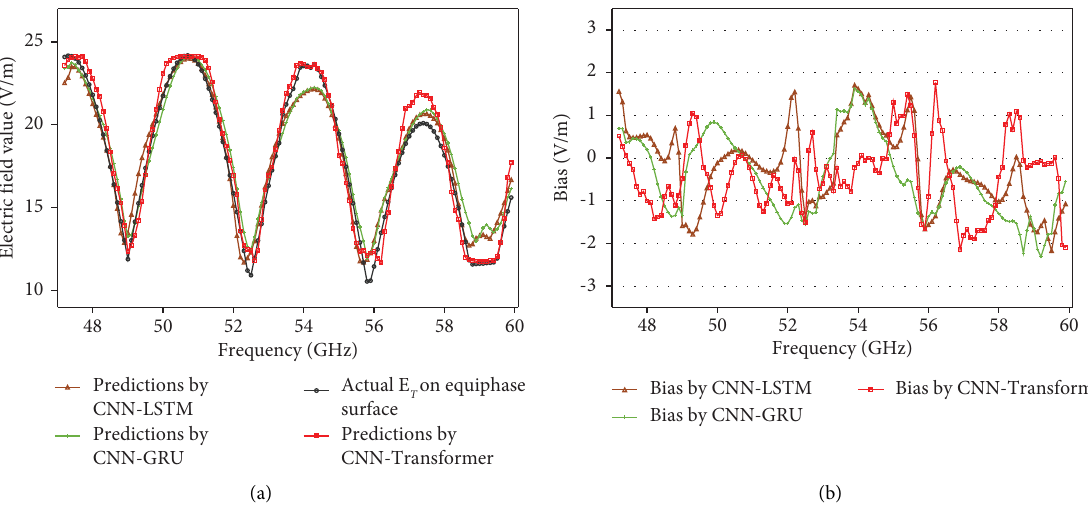
Figure 12: (a) Prediction results of a vertical dipole measured in a SAC where length h � 2U and 6U, distance d � 10m. (b) Deviation in the predicted results and the actual electric feld on the equiphase